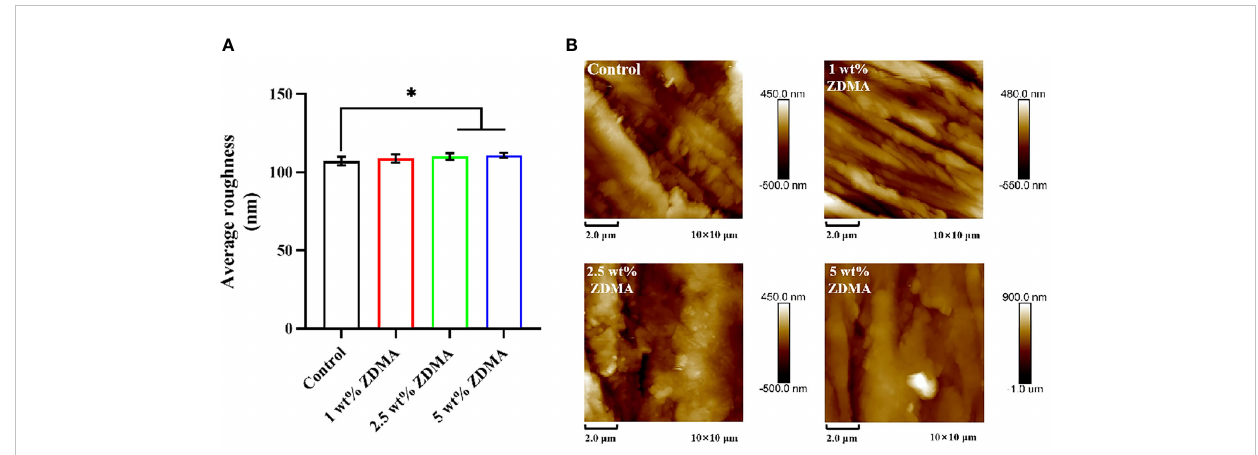
FIGURE 4 Surface roughness of each group. (A) Means ± standard deviations for Ra values of each group (*p < 0.05). (B) Representative AFM image of each group.